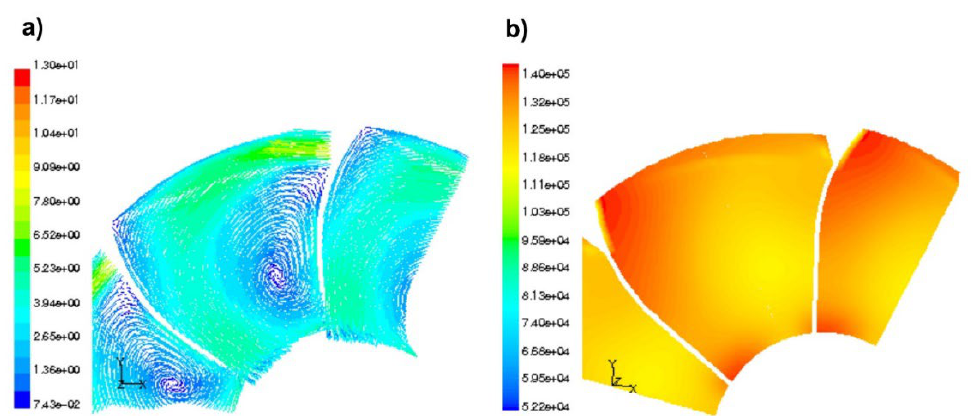
Figure 20. The field of: ( a )—velocity [m/s]; ( b )—static pressure [Pa] in the channels of the guide vanes for the d 2 / d 3 = 1 variant.